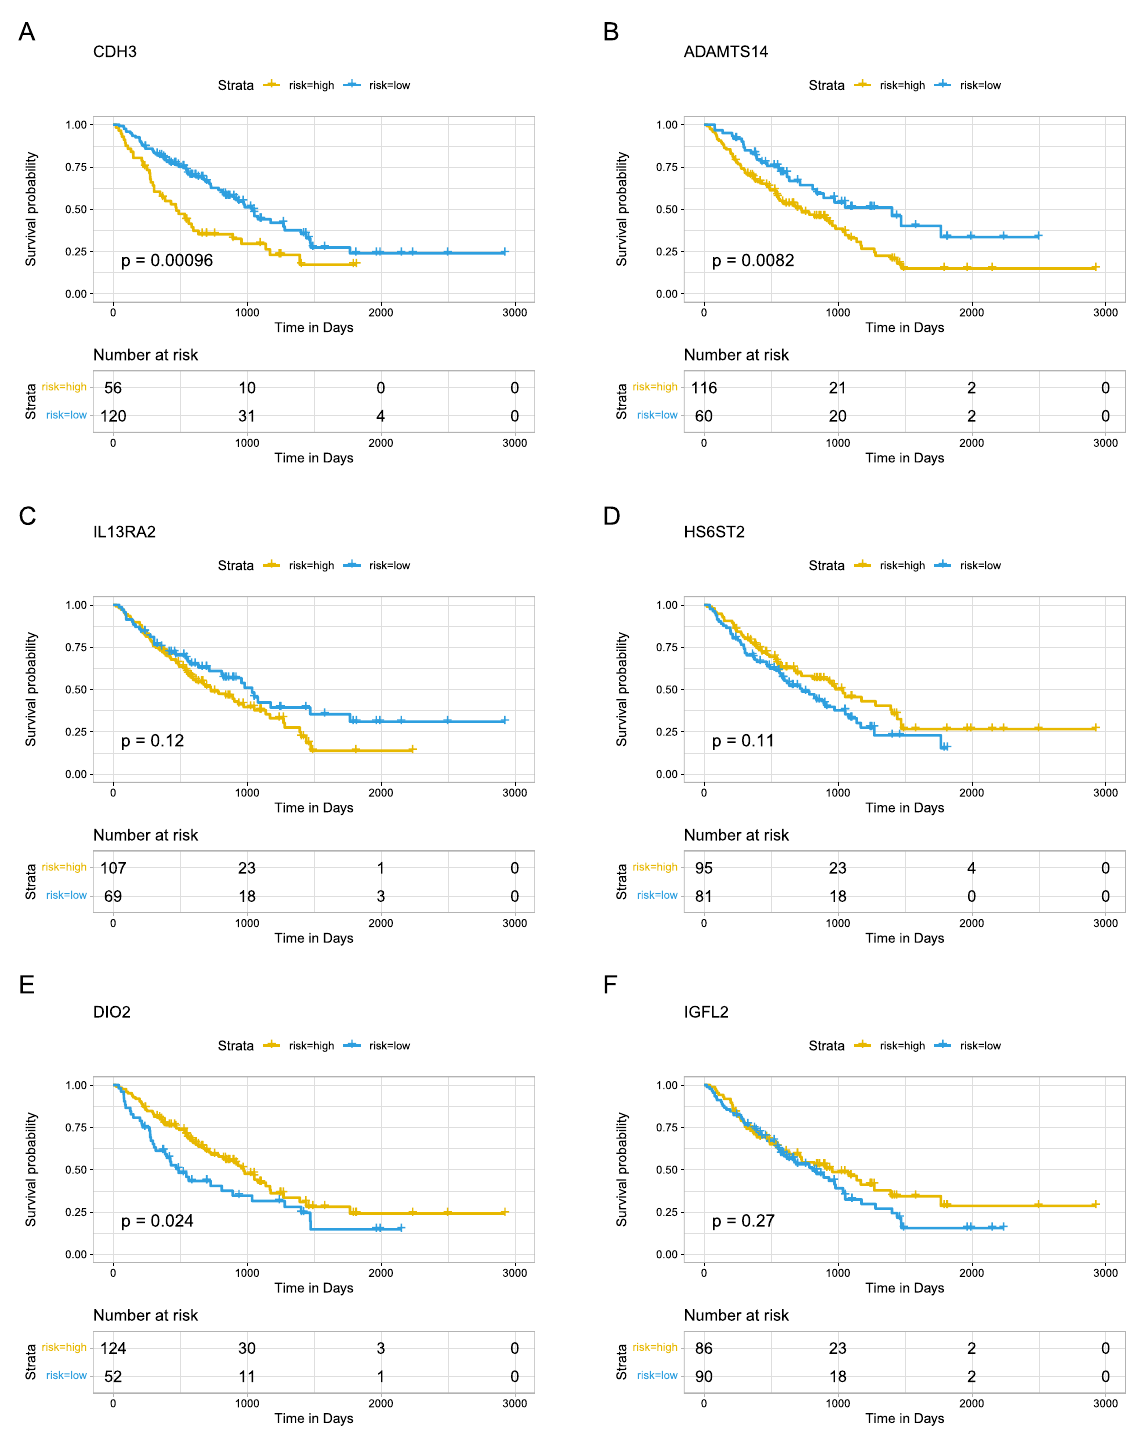
Figure 6. Survival predictive analysis. ( A ) CDH3 as a prognostic factor to evaluate the prognosis and survival status of IPF patients. ( B ) ADAMTS14 as a prognostic factor to evaluate the prognosis and survival status of IPF patients. ( C ) IL13RA2 as a prognostic factor to evaluate the prognosis and survival status of IPF patients. ( D ) HS6ST2 as a prognostic factor to evaluate the prognosis and survival status of IPF patients. ( E ) DIO2 as a prognostic factor to evaluate the prognosis and survival status of IPF patients. ( F ) IGFL2 as a prognostic factor to evaluate the prognosis and survival status of IPF patients. The x-axis represents time and the y-axis represents survival probability. The yellow line represents the high gene expression group, and the blue line represents the gene low expression group. Each point on the curve represents the patient’s survival rate at that time